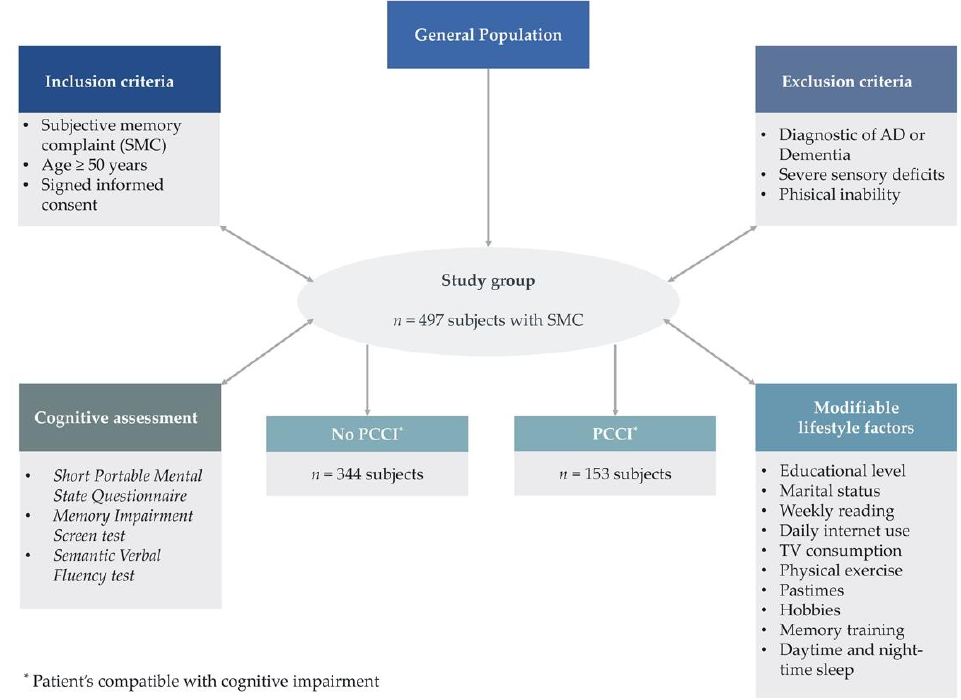
Figure 1. Diagram showing our analysis methodology. SMC: subjective memory complaint.